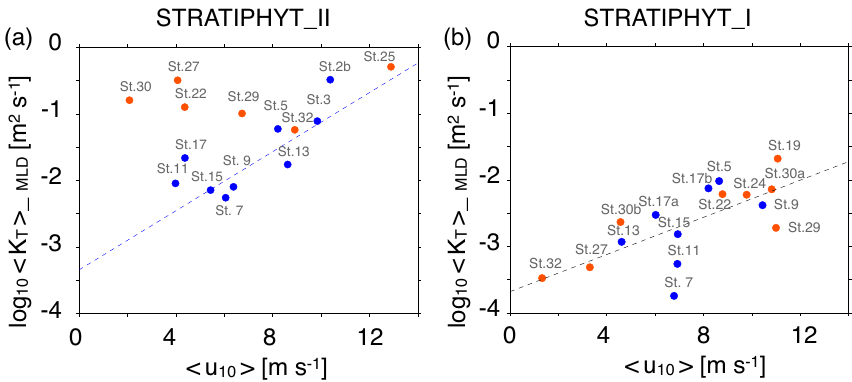
Fig. 8. Station- and column-averaged temperature eddy diffusivity, K T , in the mixed layer versus the wind speed at 10m height, u 10 . Graphs presented for (a) the STRATIPHYT-II cruise (6 April–3 May 2011), and (b) the STRATIPHYT-I cruise (15 July–9 August 2009). The stations south of 48 ◦ N are depicted in blue filled circles, and the stations north of 48 ◦ N are depicted in orange filled circles. The angle brackets indicate a station-average, and the notation MLD indicates a column-average down to the mixed layer depth (MLD). The stations north of 48 ◦ N in STRATIPHYT-II have larger MLDs than the maximum depth measured by the SCAMP, and at those stations we have performed the column-averages down to 100m. In (a) we depict the best linear least squares fit for the stations south of 48 ◦ N (log 10 h K T i MLD = 0 . 22 h u 10 i− 3 . 34) (if we consider all the stations of the cruise, the correlation between h K T i and h u 10 i is not significant). In (b) we depict the best linear least squares fit for all the stations of the cruise (log 10 h K T i MLD = 0 . 14 h u 10 i− 3 . 68). We have not considered stations with less than 3 profiles, and the stations where the anemometer was not